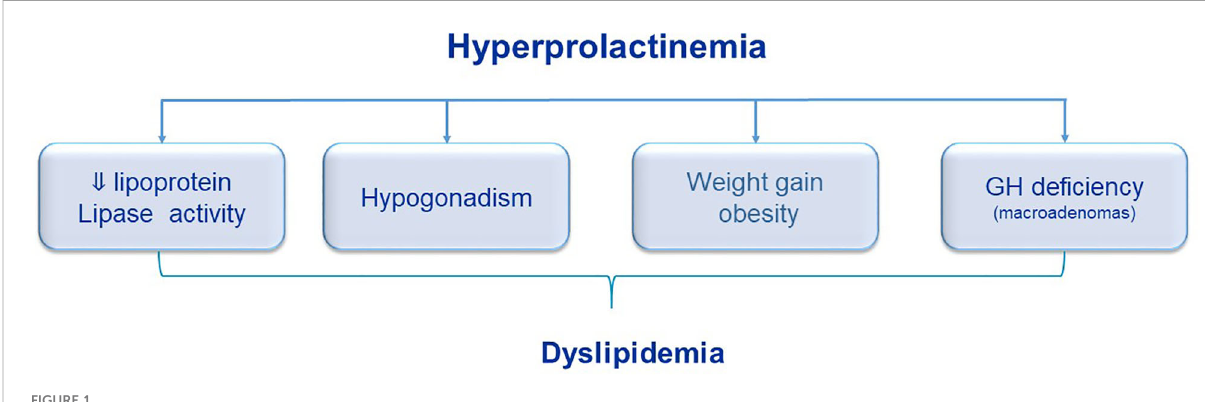
FIGURE 1 Potential role of hyperprolactinemia on